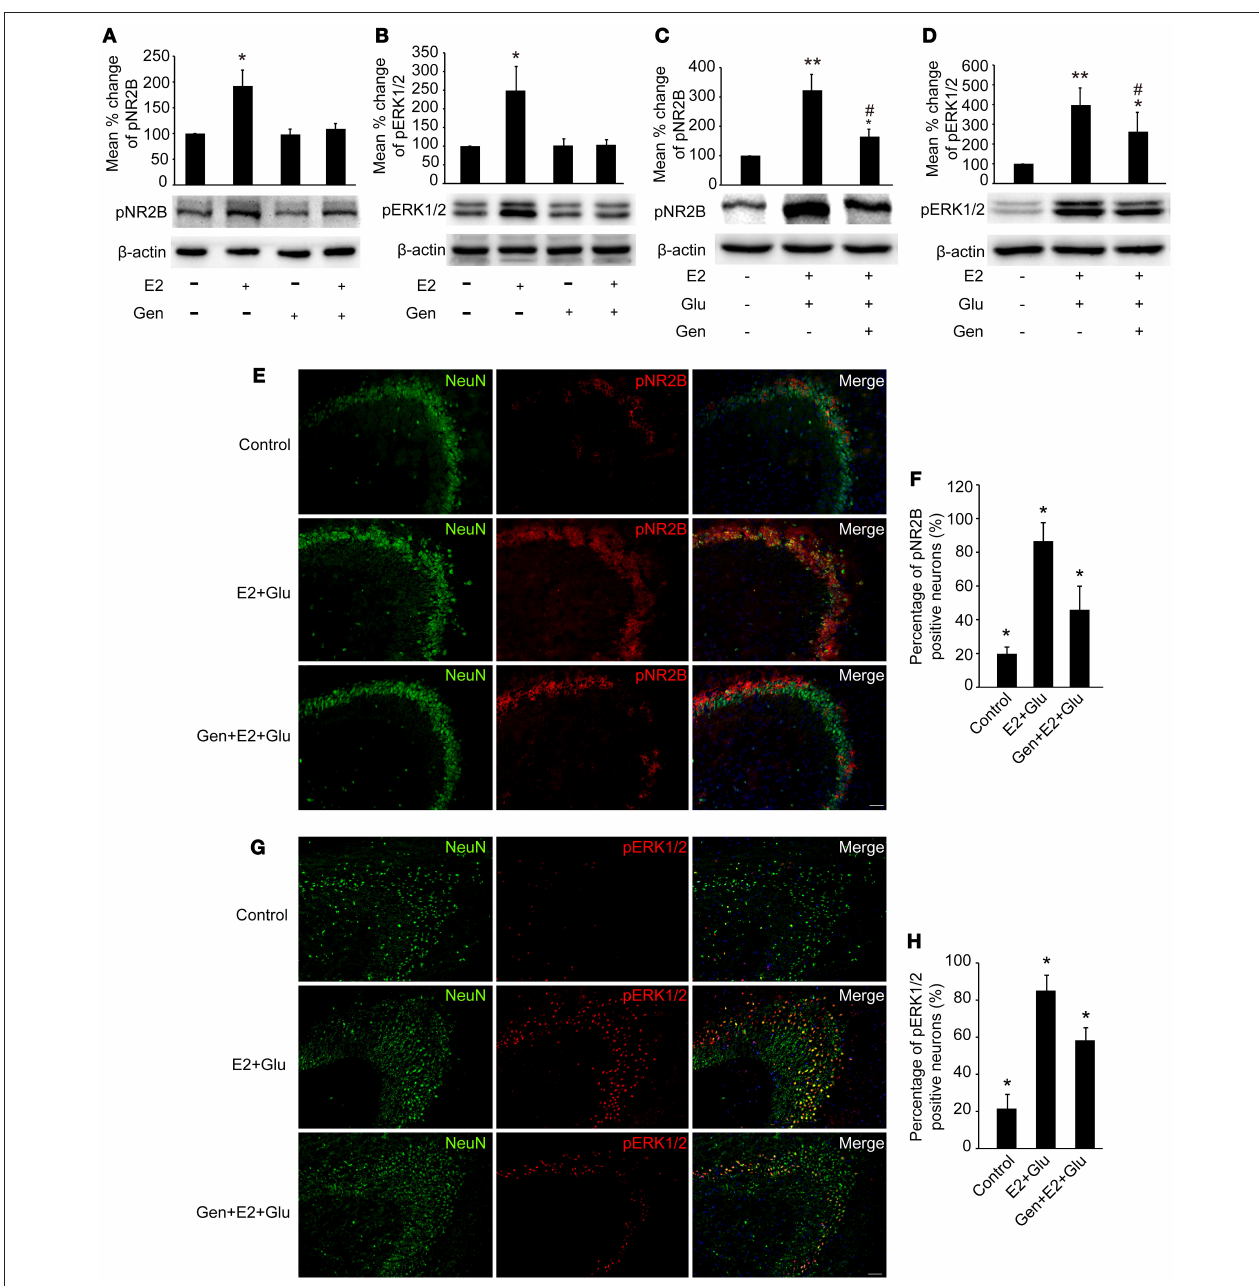
FIGURE 7 | Genistein blocked E2-induced pNR2B and pERK1/2 upregulation, and partially blocked E2-potentiated glutamate-evoked pNR2B and pERK1/2 upregulation in the hippocampus. OVX rats were assigned to 4 groups for western blot analyses: (1) no injections, (2) E2 replacement, (3) genistein treatment, and (4) genistein pretreatment combined with E2 replacement. (A,B) Representative western blots of pNR2B and pERK1/2 after E2 and genistein treatment. Quantification of protein levels was normalized against loading control β -actin and presented as the relative density compared with the control group (OVX). * P < 0.05 vs. the rest groups; n = 5, per group. To examine the effect of genistein on E2 and glutamate-evoked upregulation of pNR2B and pERK1/2, OVX rats were assigned to 3 groups respectively for protein quantitative detection and immunohistofluorescence staining: (1) no injections, (2) E2 replacement combined with glutamate injections, and (3) genistein pretreatment combined with E2 and glutamate injections. (C, D) Representative western blots of pNR2B and pERK1/2 after E2, glutamate and genistein treatment. Quantification of protein levels was normalized against loading control β -actin and presented as the relative density compared with the control group. * P < 0.05, ** P < 0.01 vs. control group (OVX); # P < 0.05 vs. E2 + Glu group; n = 5, per group. (E,G) Representative fluorescence photomicrographs showing the pNR2B and pERK1/2 positive neurons in the CA3 region of hippocampus after E2, glutamate and genistein treatment; Scale bar = 50 µ m. (F,H) The percentages of pNR2B and pERK1/2 positive neurons in the CA3 region of hippocampus after E2, glutamate and genistein treatment; * P < 0.05 comparison among the three groups; n = 4, per group. OVX = ovariectomy; E2 = 17 β -estradiol; Glu = glutamate; Gen = genistein; pNR2B = phosphorylated NR2B subunit of the N-methyl-D-aspartate receptor; pERK1/2, phosphorylated (p44/42) mitogen-activated protein kinase; IR, immunoreactive.